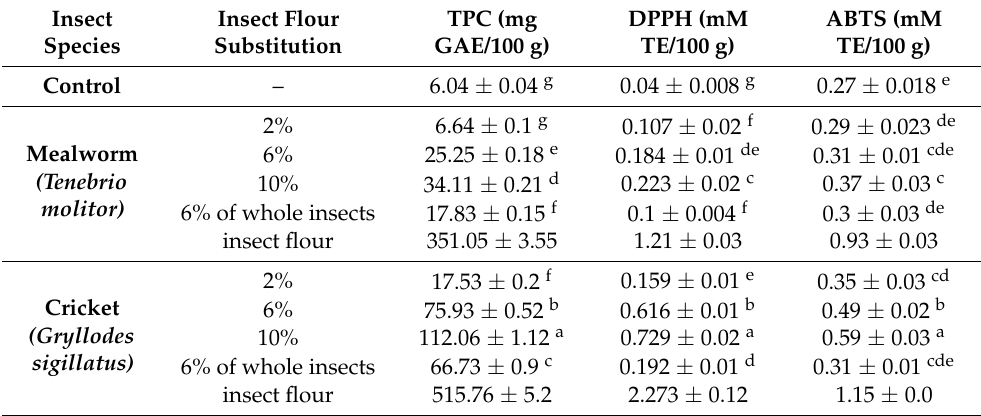
Table 7. Antioxidant properties of